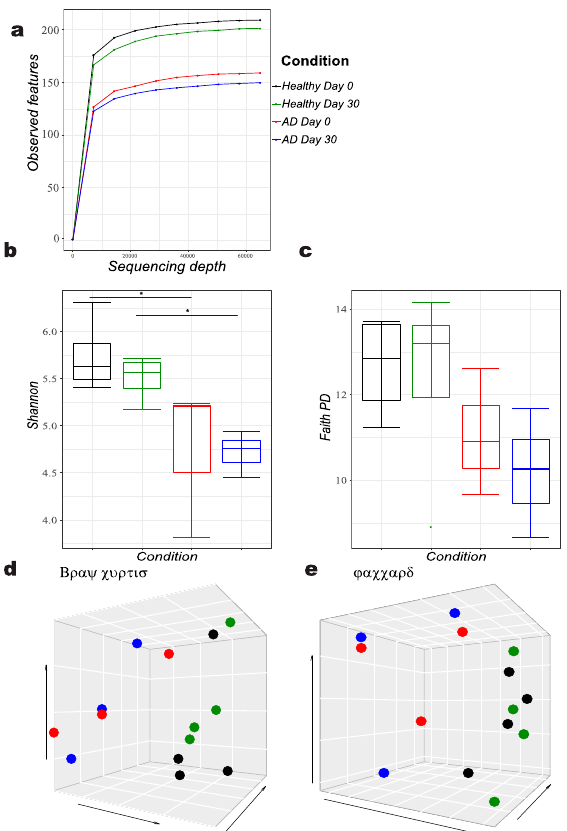
Figure 1. Diversity analysis of atopic versus healthy dogs, showing following features: ( a ) Alpha rarefaction, ( b ) Shannon alpha diversity index B, ( c ) Faith’s phylogenetic diversity (PD) index, Principal coordinates analysis ( d ) Bray Curtis and ( e ) Jaccard diversity matrices.